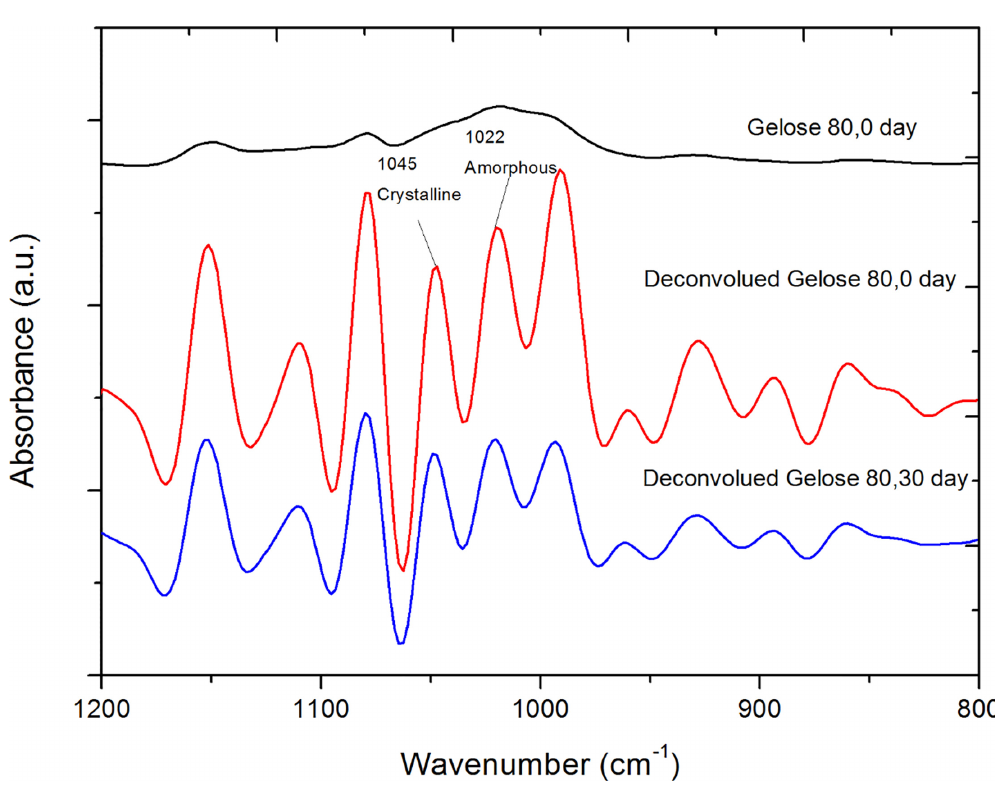
Fig 4. The original and deconvoluted FTIR spectrum of maize starch Gelose 80 after 0 and 30 days storage after HHP treatment (pressure releasing rate: